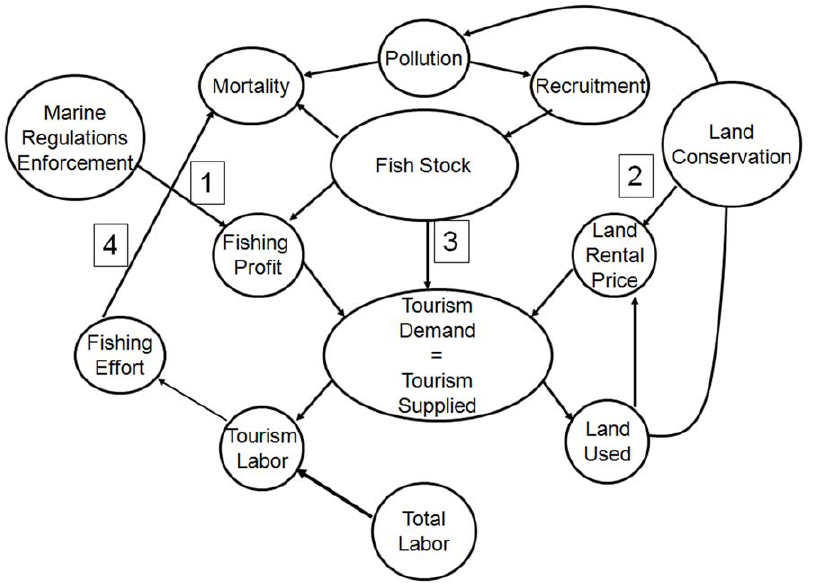
Figure 1. Conceptual diagram of the simulation model of primary interactions between model components. Conservation options act on the system by increasing the land rental price or increasing the cost of fishing. Pollution is driven by land use and impacts the fish stock through recruitment and mortality. Fish stock is also impacted by fishing effort through harvest. Wage rate is affected by fish stock and cost of fishing. Demand for tourism is influenced by the fish stock, while the demand, wage rate, and land rental price determine the allocation of land and tourism labor. (1) Shows where fisheries enforcement interacts with the model by increasing the cost of fishing and decreasing the profit from fishing. (2) Land conservation interacts with the model by increasing the land rental price and decreasing the amount of land used. (3) Fish stock affects the quantity of tourism demanded by increasing or decreasing the amount people are willing to pay for a unit of tourism. (4) Fishing effort alters fish mortality and controls the size of the fish stock.